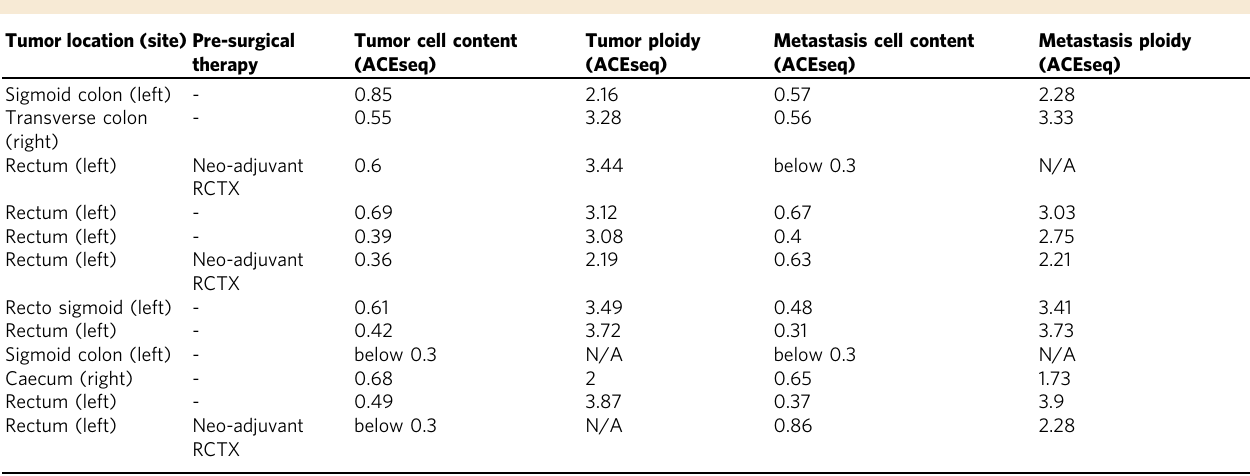
Table 2 Patient clinical and sample information,